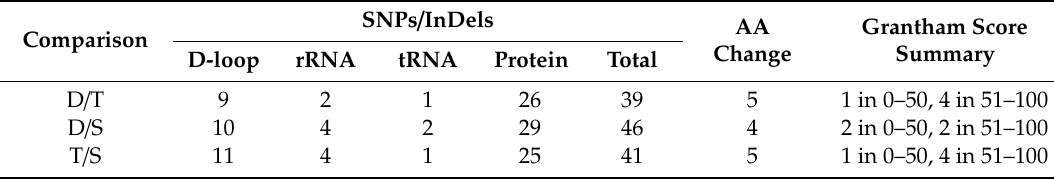
Table 1. Mitogenome divergences among the mitochondrial haplotypes.